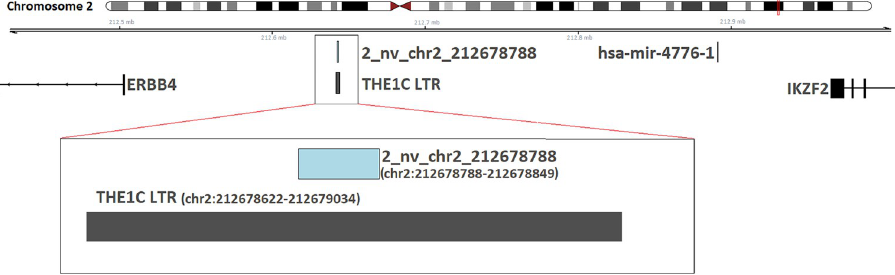
Fig 7. Visualisation of 2_nv_chr2_212678788 novel miRNA genomic position. Genomic position (GRCh38) of novel miRNA 2_nv_chr2_212678788 sequence located in THE1C